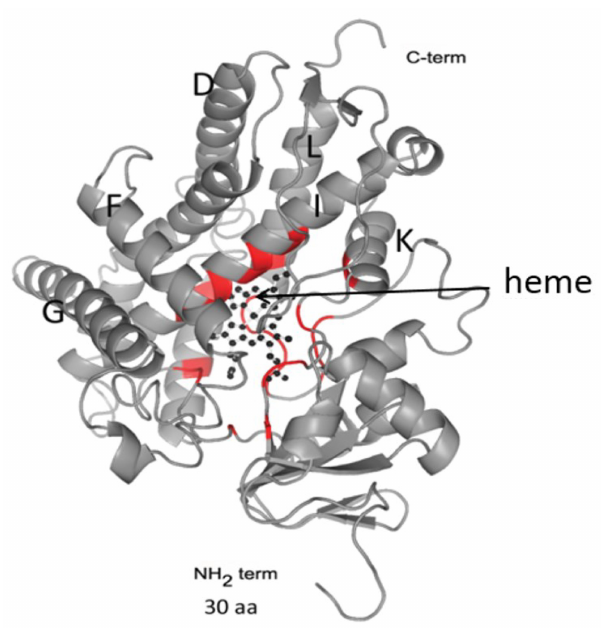
Figure 2. A 3D structure modeling of OfCYP (Phyre2). The arrow indicates the position of the heme within the globular region of the protein. Regions of the protein taking part in heme positioning are highlighted in